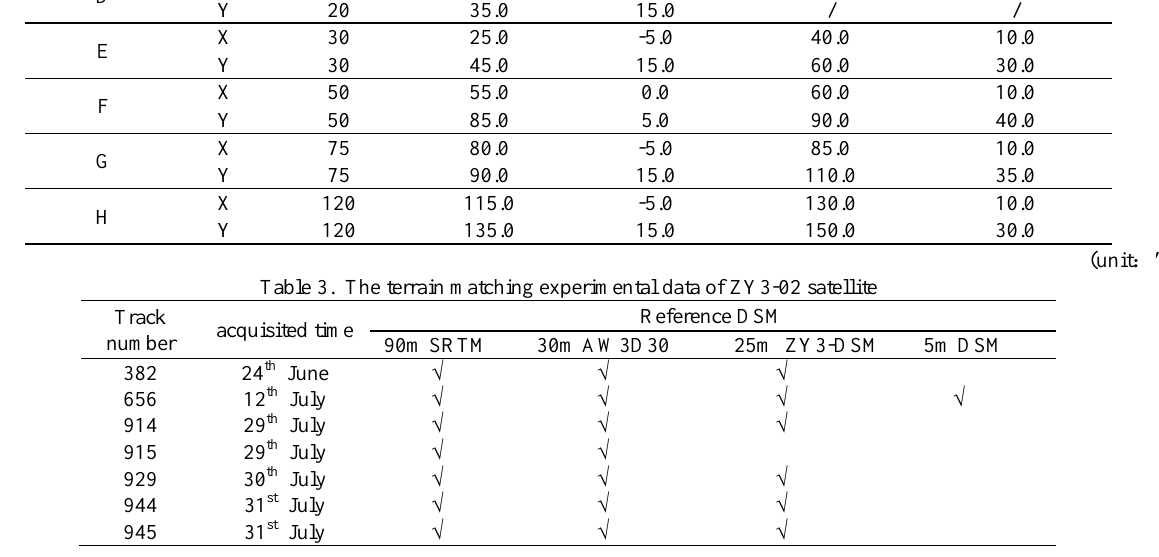
Table 4. Pointing angle calibration results of multiple tracks ZY3-02 laser